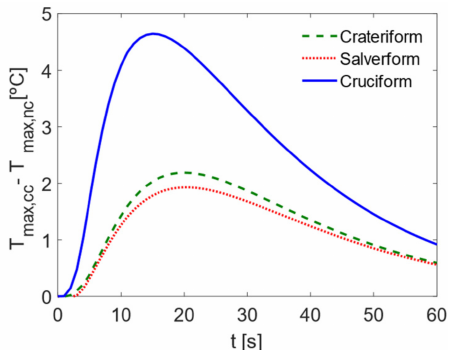
Figure 7. Time evolution of the reduction in maximum temperature attained by the novel configura- tions (nc) respect to the common configurations